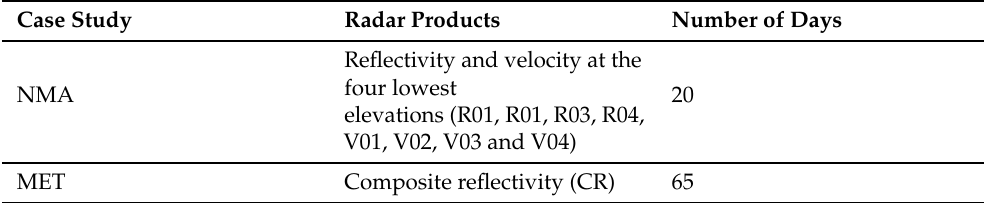
Table 1. A description of the datasets that were used in our case